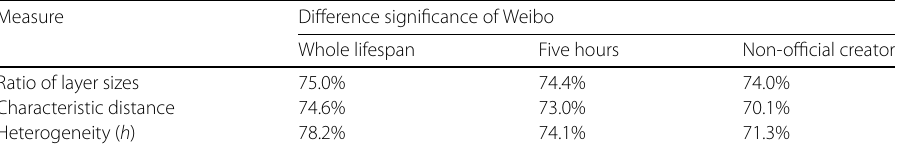
Table 2 Comparison between three methods Measure Difference significance of Weibo Whole lifespan Five hours Non-official creator Ratio of layer sizes